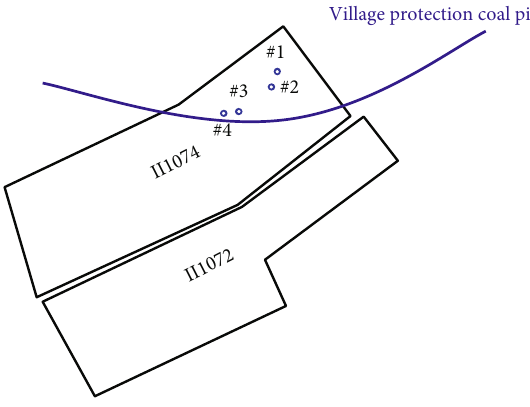
Figure 10: Plan view of II1074 longwall